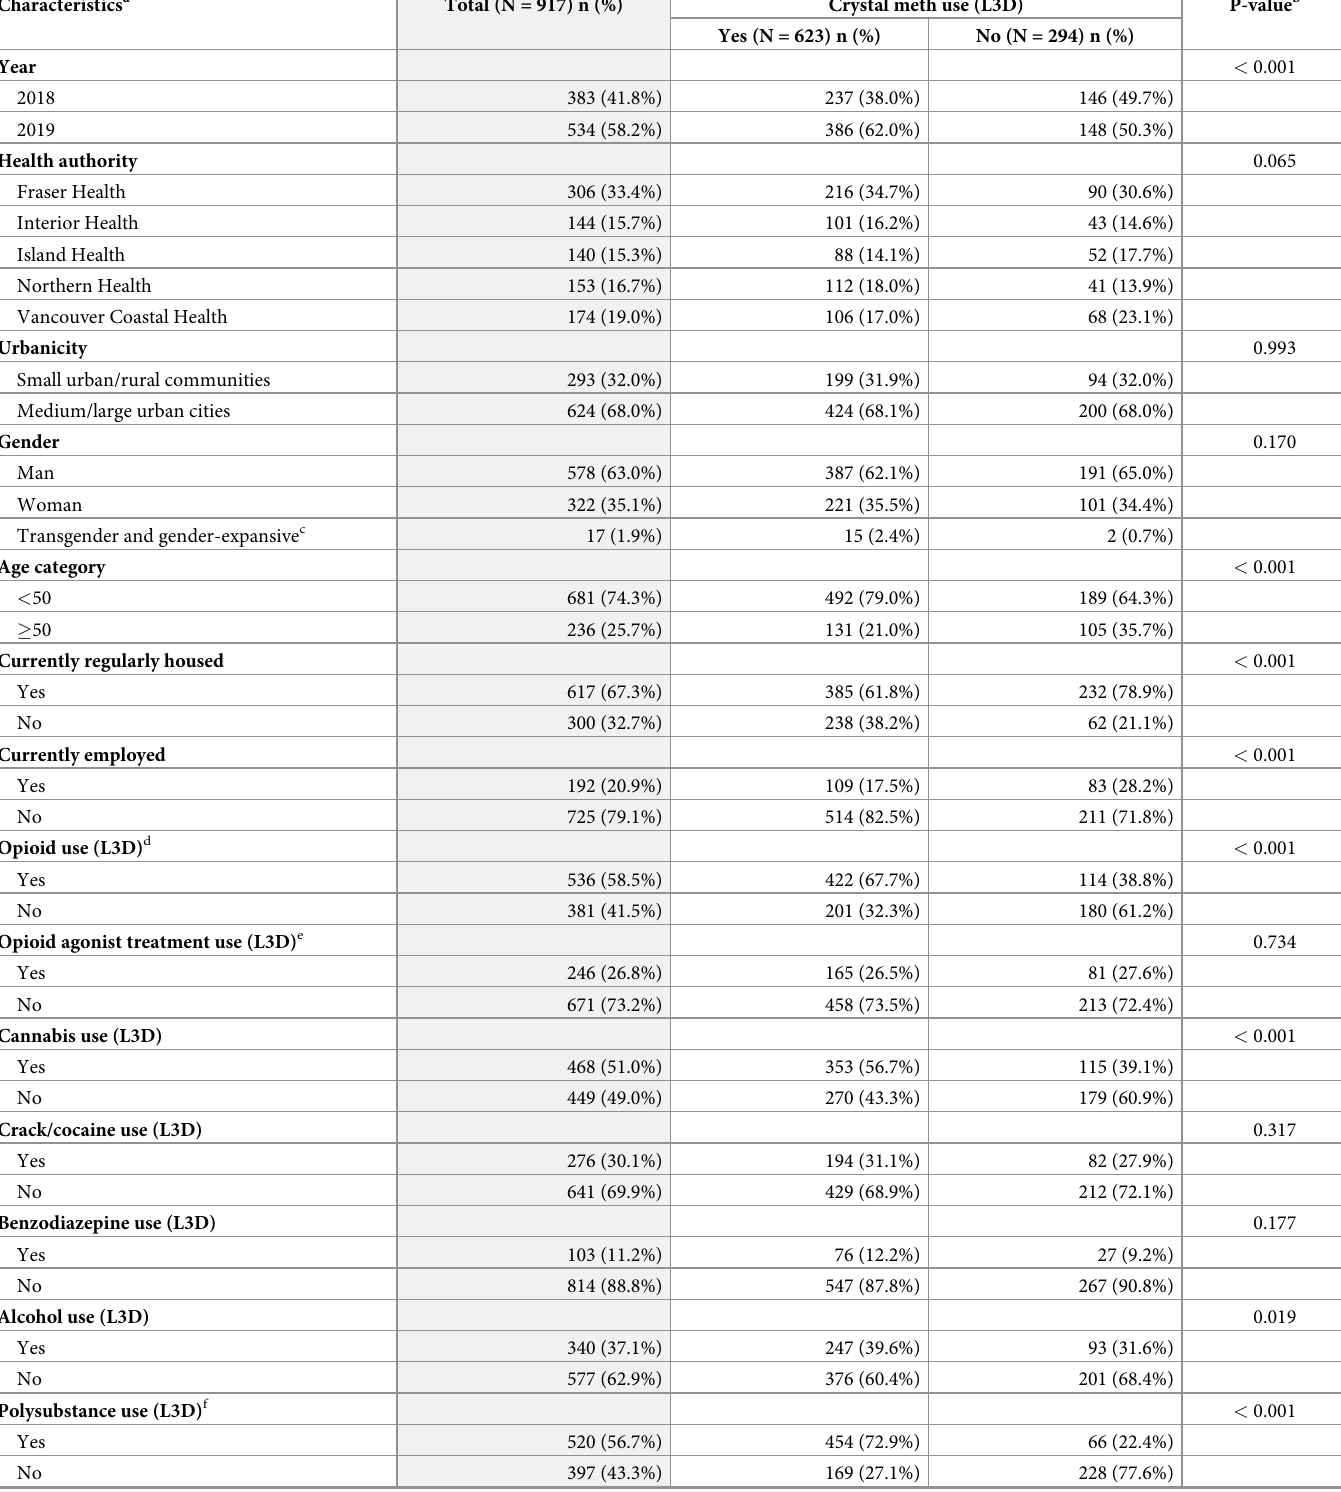
Table 2. Characteristics of participants in the 2018 and 2019 Harm Reduction Client Survey (HRCS) stratified by past three-day self-reported crystal meth use (N = 917). Characteristics